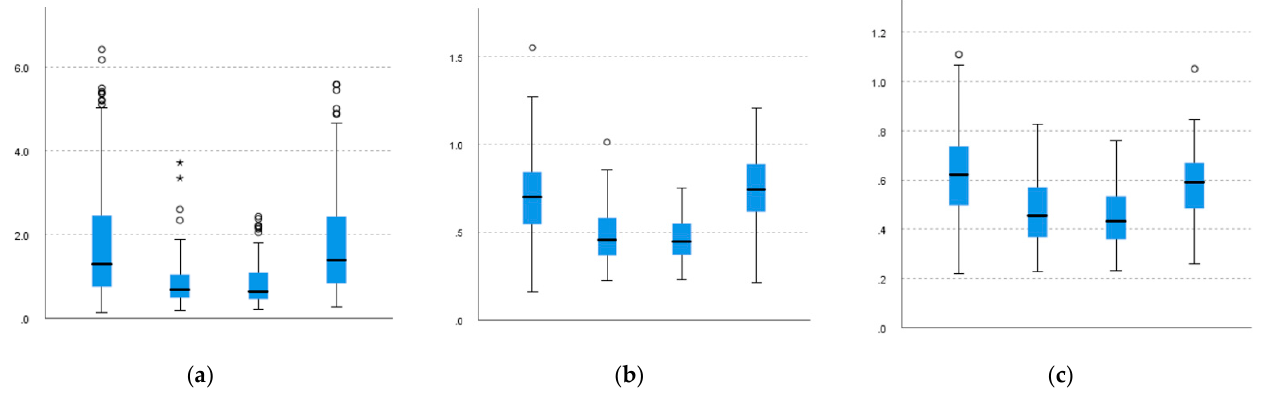
Figure 10. Comparison of waist vibration and moving distance of hands. ( a ) STDwaist. ( b ) DRight. ( c ) DLeft. Table 9. Post hoc testing of waist vibration and moving distance of hands.